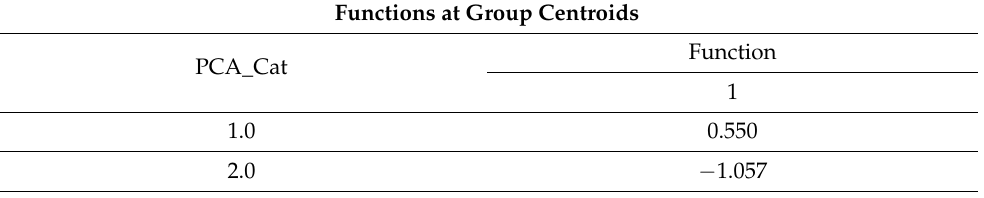
Table A11. Centroid